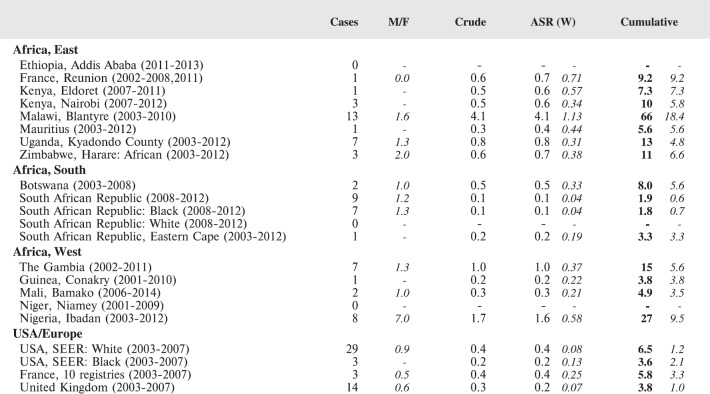
Crude, age-standardised (world) and cumulative (0–14) incidence rates (per million) and standarderrors—hepatocellular carcinomas.